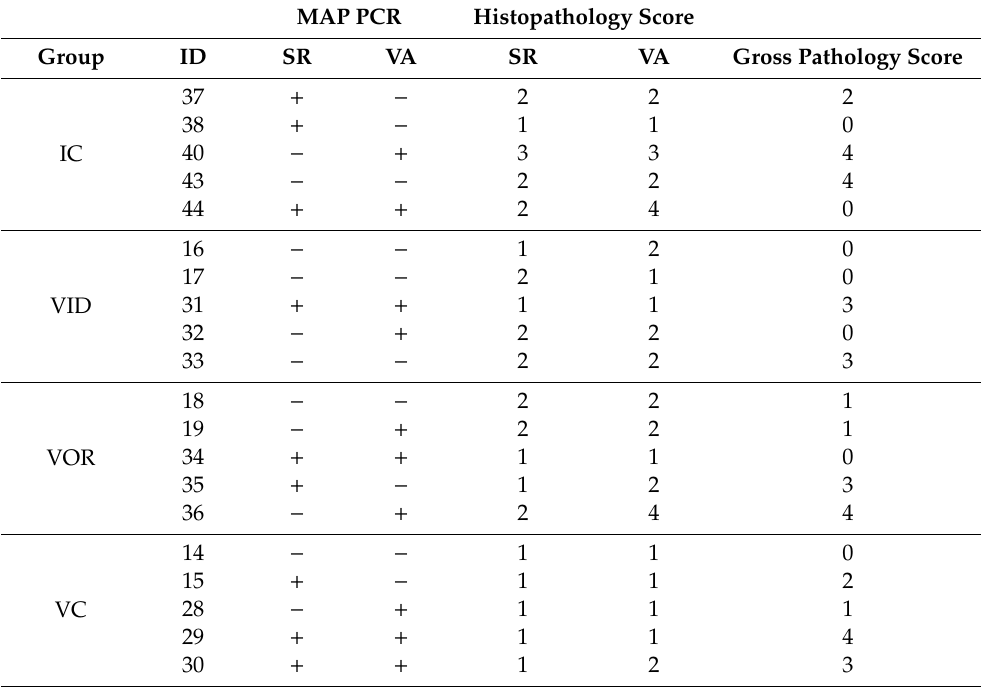
Table 2. Infection outcome in MAP infected